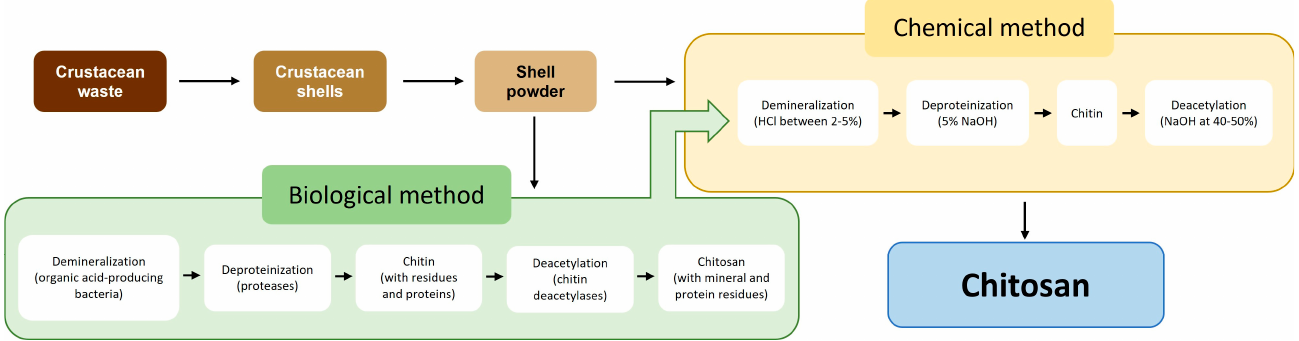
Figure 1. Methods of chitosan extraction [10].